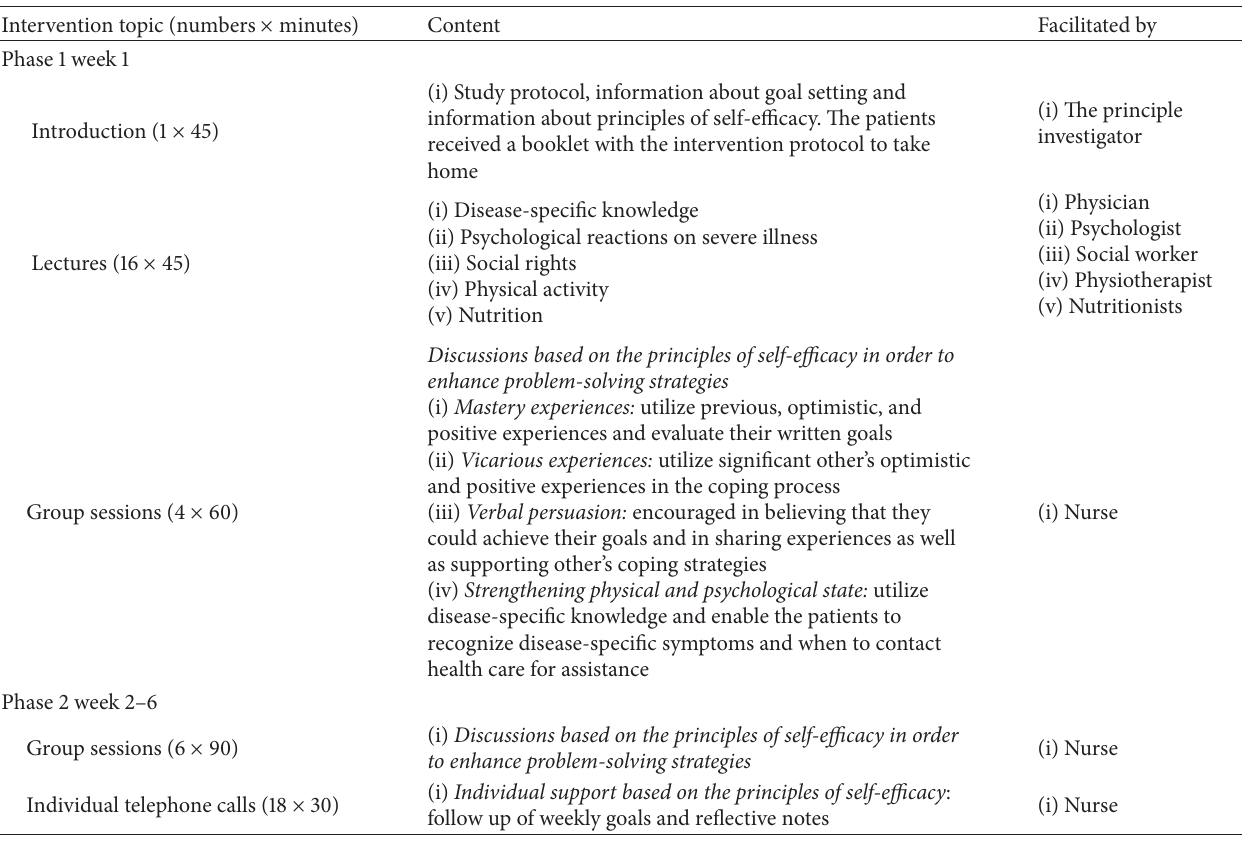
Table 1: Description of the 26-week